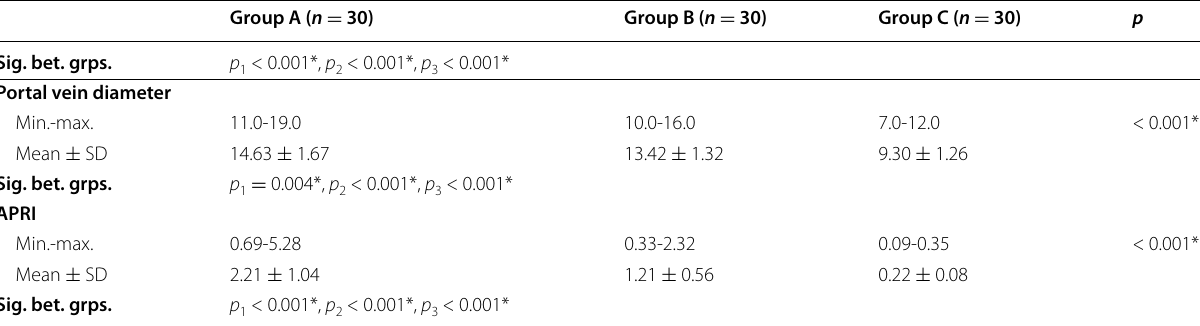
Table 2 Comparison between groups A and B according to Child‑Pugh classification and score